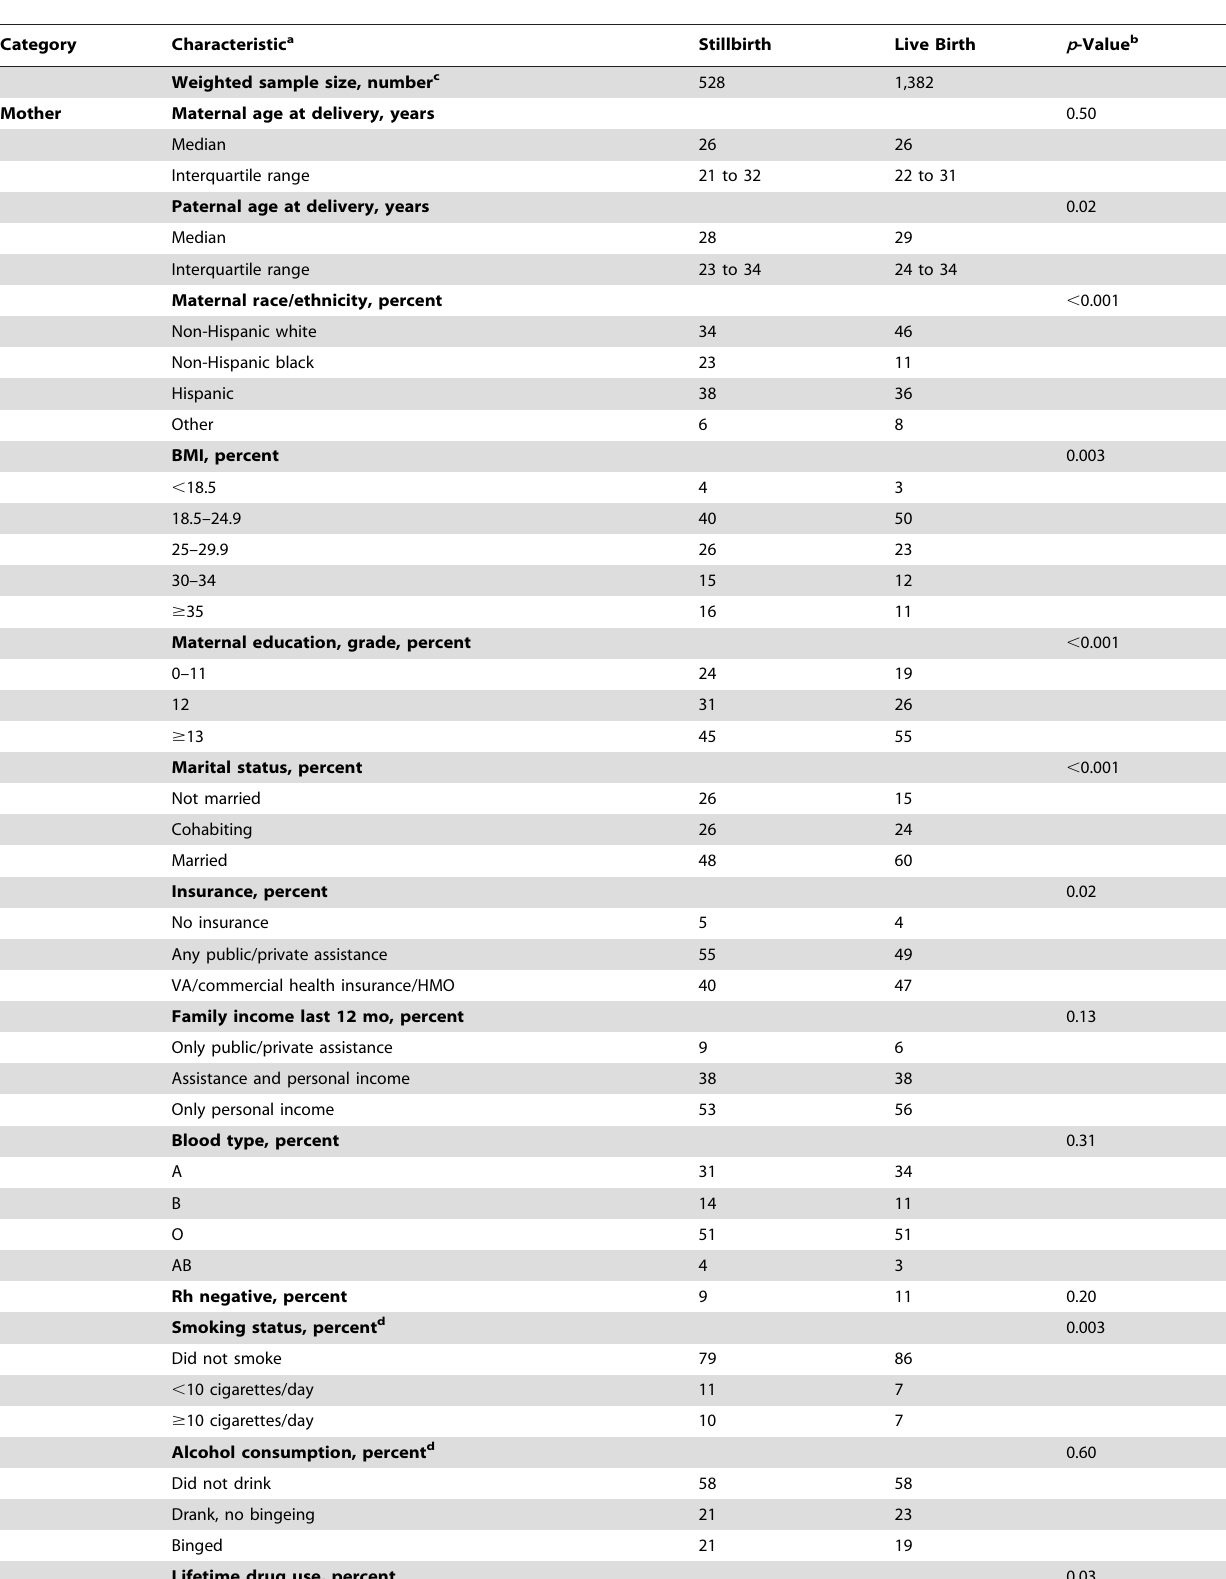
Table 1 . Characteristics of stillbirth and live birth